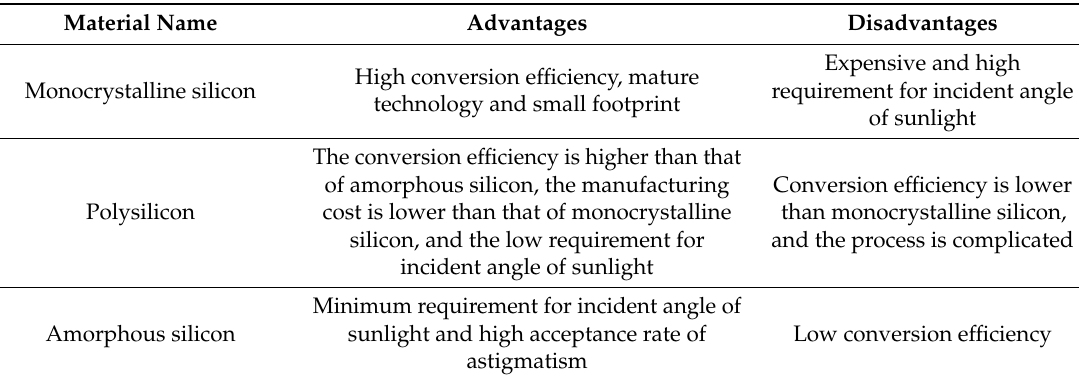
Table 2. Advantages and disadvantages of different silicon solar cells.